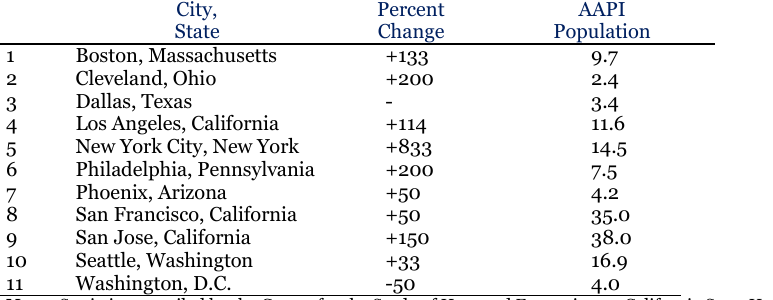
Table 2. Percent Change in Number of Hate Crimes Targeting AAPI resident in US Cities and APPI Population by